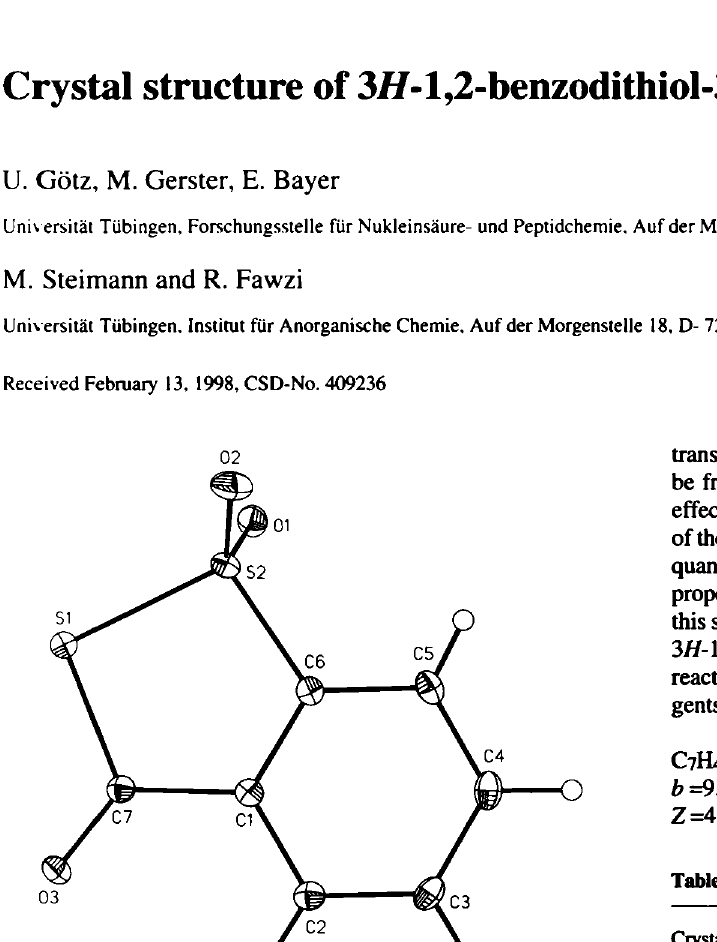
Table 1. Parameters used for the X-ray data collection Ciystal: